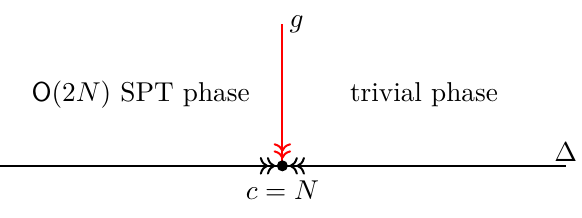
Figure 1 . Phase diagram of the lattice GN Hamiltonian from eq. (3.9) with additional SSH mass term from eq. (3.5). The point g = ∆ = 0 is the lattice realisation of the N -flavour free fermion conformal field theory, which plays the role of a UV fixed point. For negative/positive mass perturbations the ground state is in a symmetry protected/trivial gapped phase respectively. The GN model has no explicit mass term and corresponds to a first order phase transition between those phases, i.e. it has two gapped ground states with zero and non-zero topological invariant respectively. The continuum limit of the Gross Neveu model approaches the c = N point via the red arrows, while the black arrows denote the continuum limit of N massive